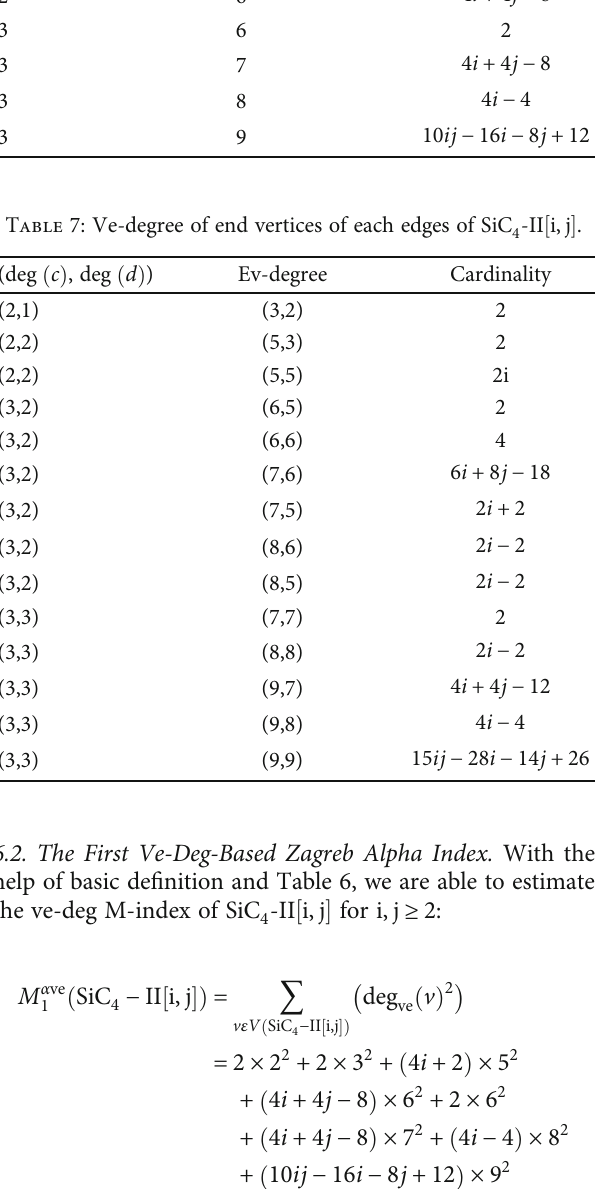
Table 2: Vertex degree with corresponding cardinality.